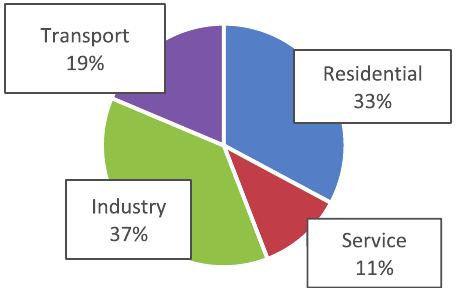
Figure 1. Sectoral energy share (%). Calculated based on Department of Renewable Energy